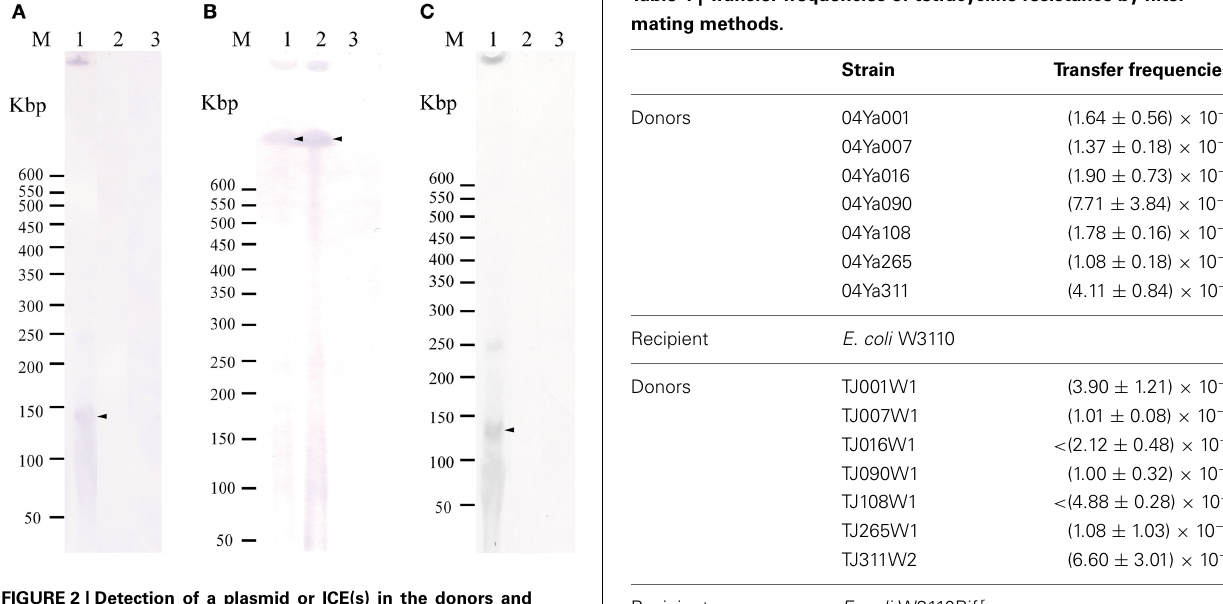
FIGURE 2 | Detection of a plasmid or ICE(s) in the donors and transconjugants using Southern hybridization following to pulsed field gel electrophoresis with the tet (M) probe (A), traI -ICE Vch Mex probe (B), and rep -pAQU1 probe. (C) Lane: M, DNA size standard (lambda ladder); 1, 04Ya007; 2, TJ007W1; 3, W3110. Approximately, 20ng of DNA was loaded in each lane. Arrows indicate the positions of the bands.